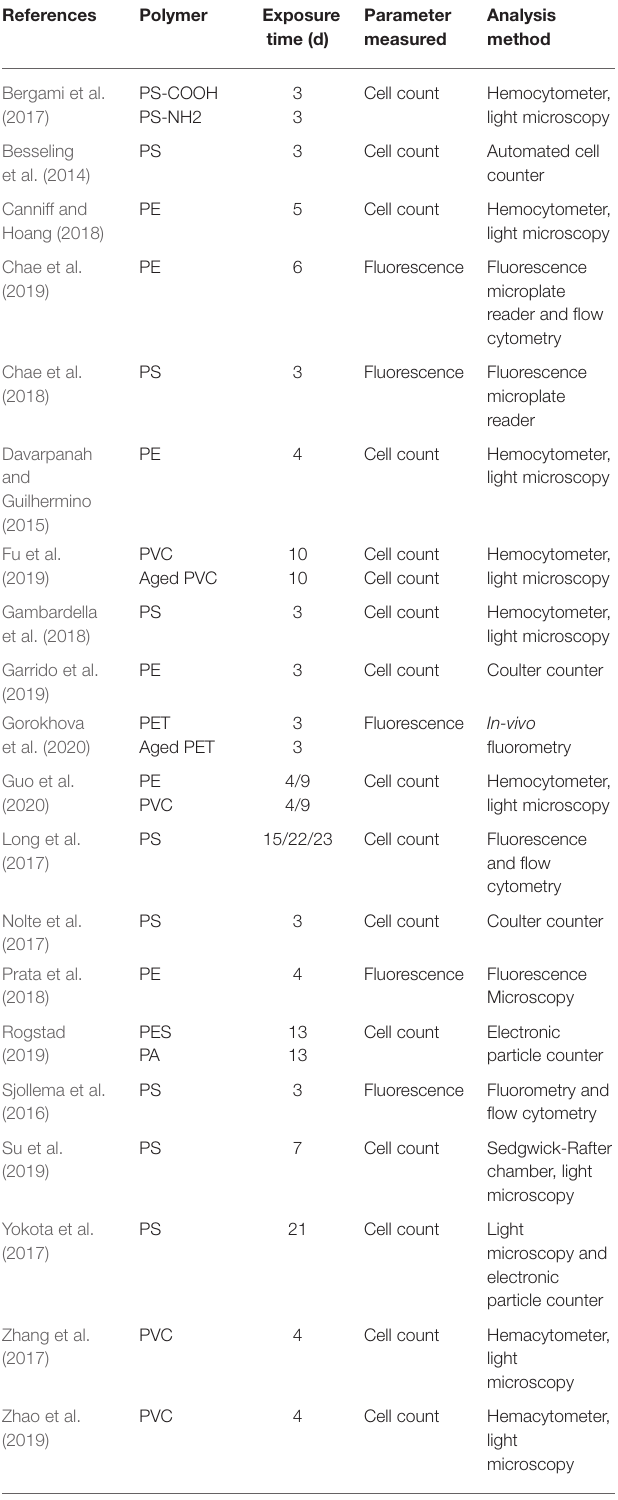
TABLE 1 | Overview of studies testing micro- and nanoplastic effects on algal growth that were included in the